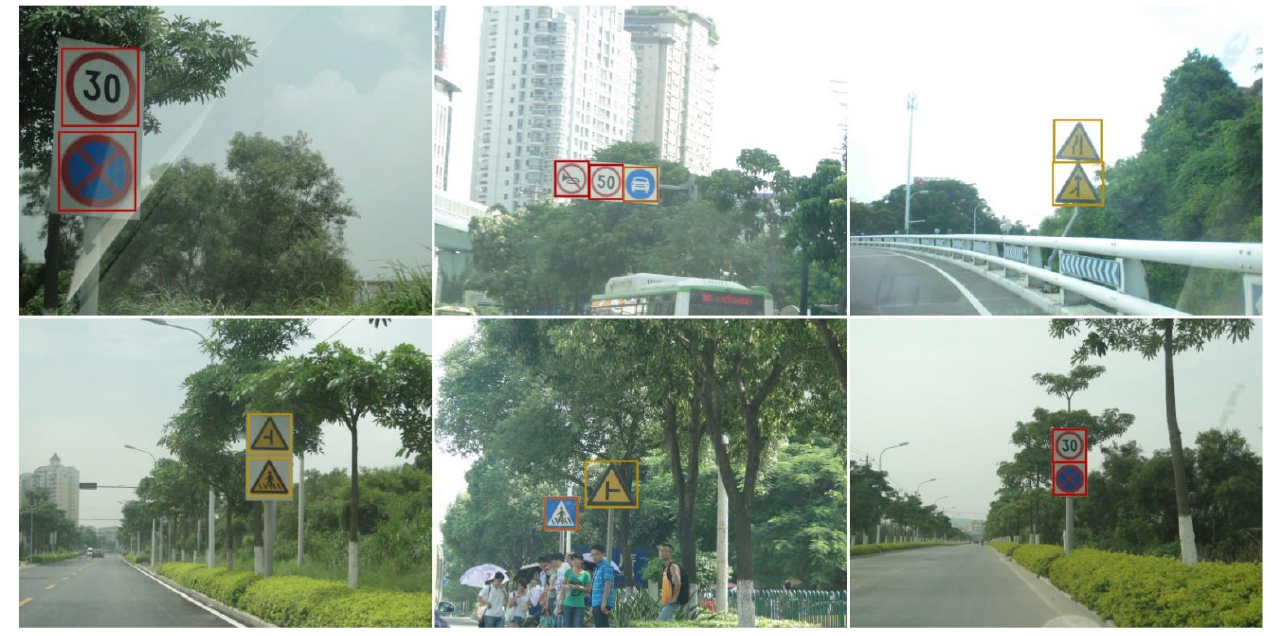
Figure 11. Detection results for the BCTSDB dataset.